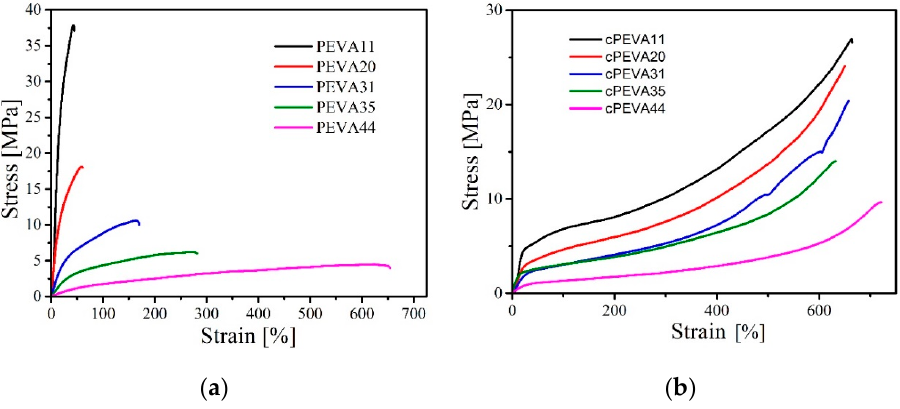
Figure 9. Stress–strain curves of PEVAs ( a ) and cPEVAs ( b ) determined by tensile tests at ambient